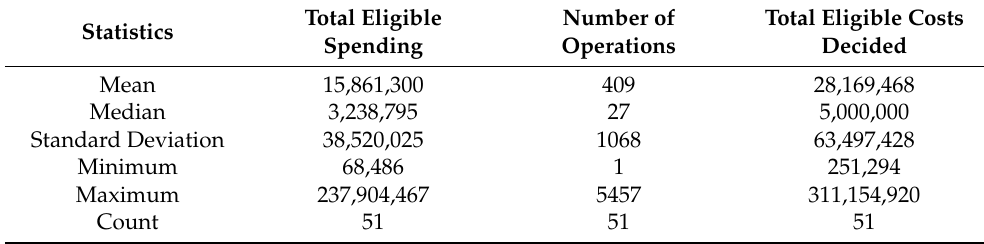
Table 3. Descriptive statistics of the inputs and outputs.